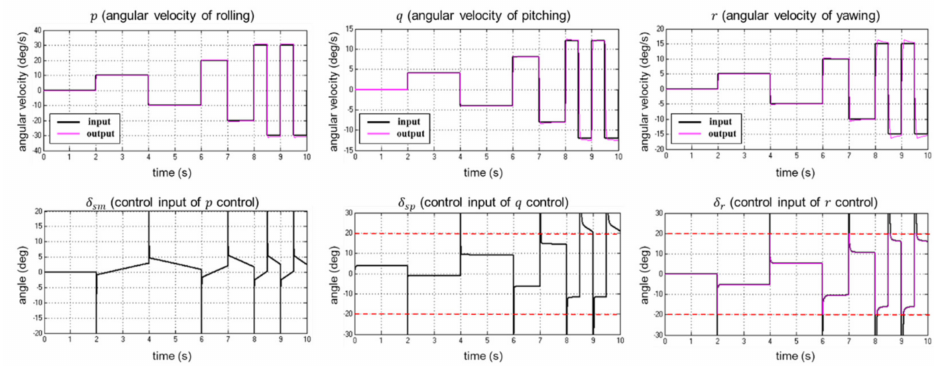
Figure 4. PID control simulation results without disturbances.